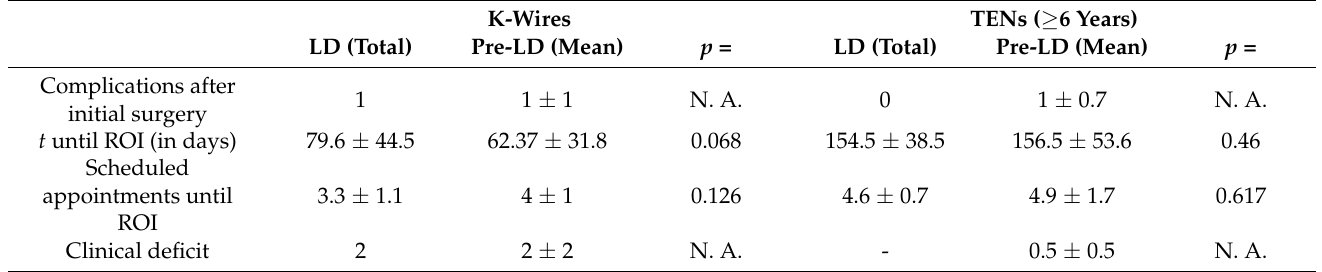
Table 1. Comparison of LD and pre-LD periods with presentation of p -values (N.A. = not applicable). K-Wires